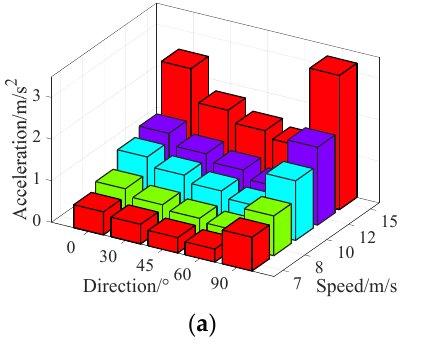
Figure 15. The installation of the five sensors.